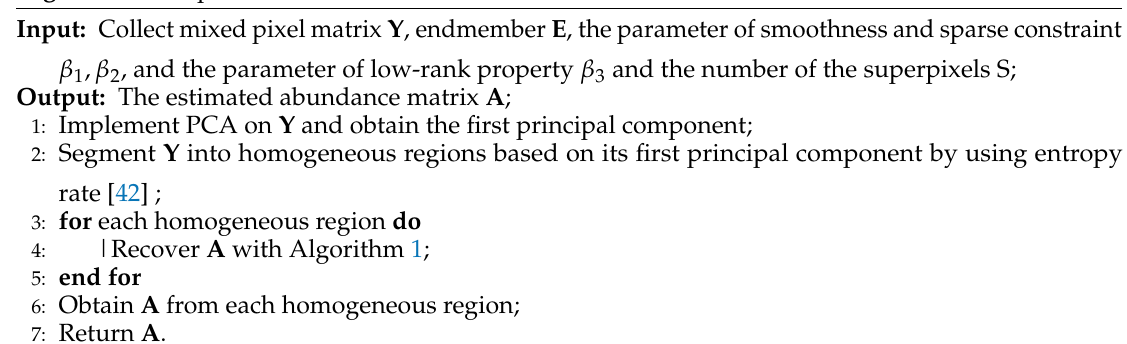
Algorithm 2 Proposed